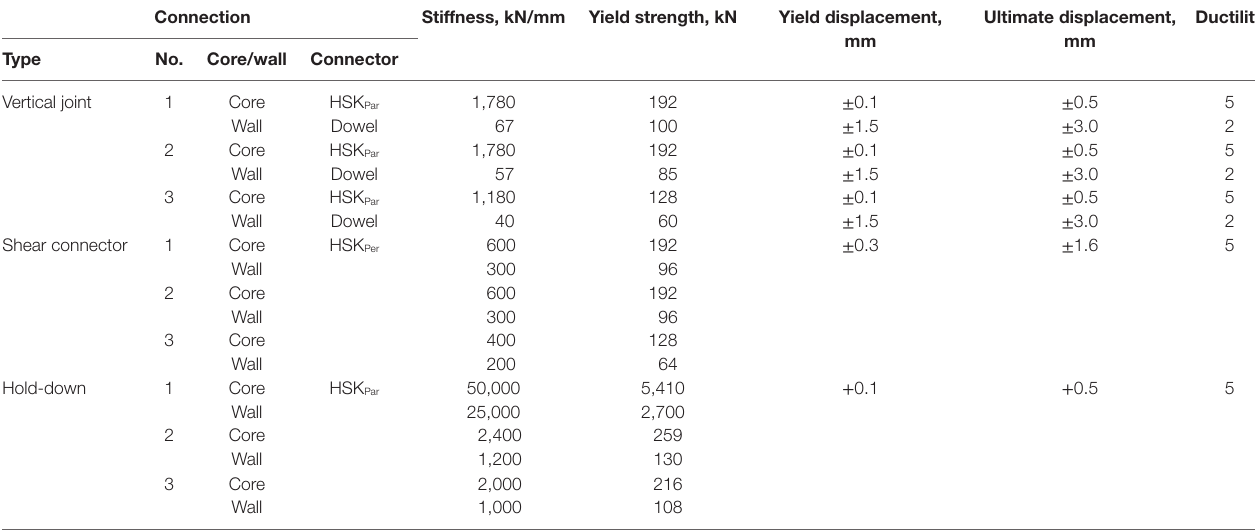
TaBle 2 | Connection model